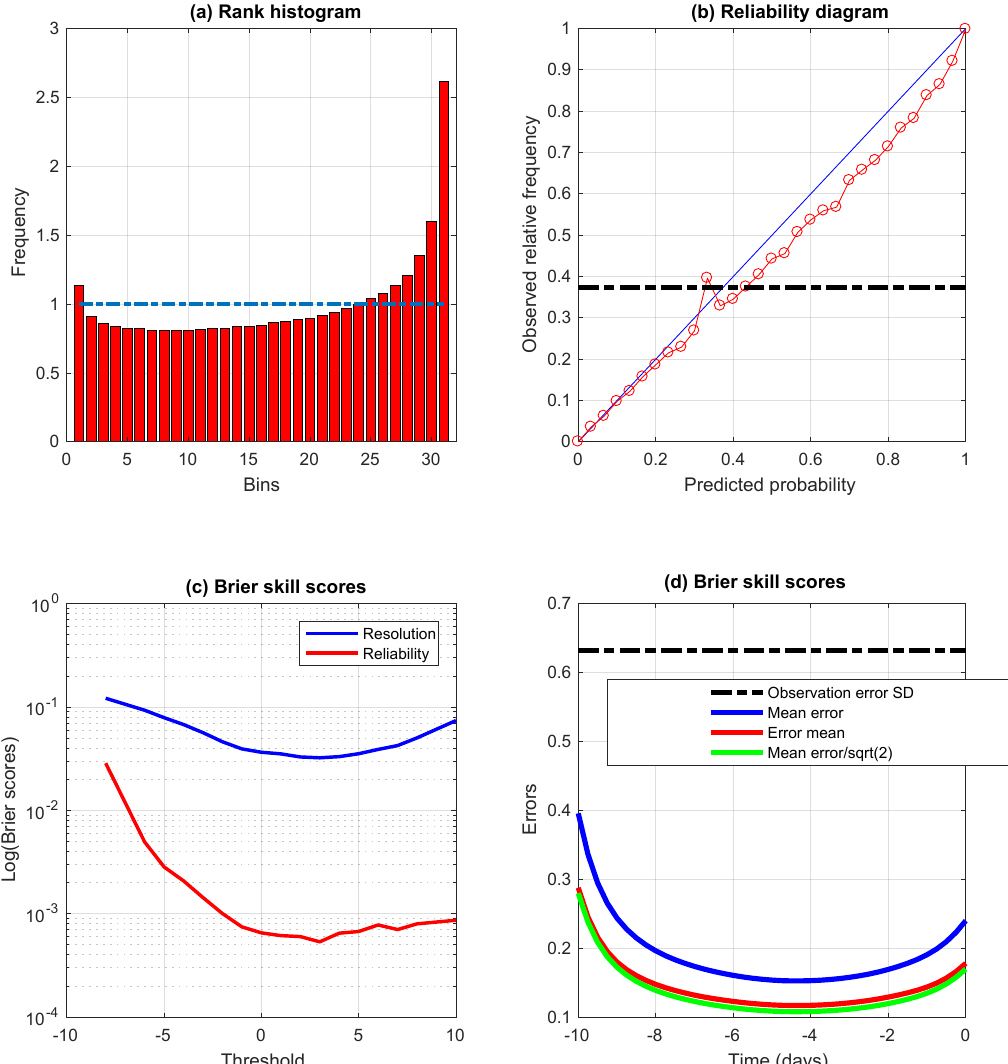
Figure 5. Same as the lower four panels of Fig. 1, restricted to minimizations that lead to the absolute minimum of the objective function (I-9), as identified from the value of the minimum itself (see Fig. 2). The diagnostics have been computed on 1443 realizations. The reliability diagram (b) is relative to the event E = { x < 0 . 33 } , which occurs with frequency 0.38. In panel (d) , which shows the RMS estimation errors along the assimilation window, the green curve has been obtained by dividing the values on the blue curve by a factor